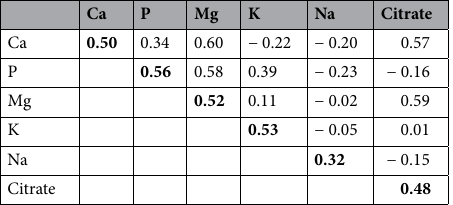
Table 2. Estimates of heritability (in bold, diagonal) and genetic correlation (above the diagonal) for the concentrations of minerals and citrate in milk (SE < 0.01).